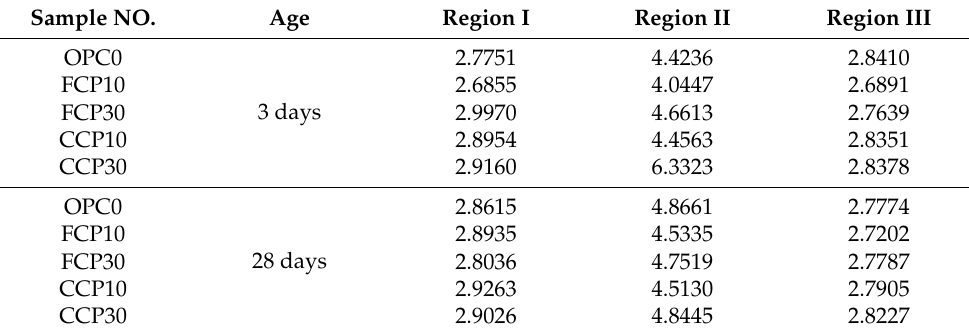
Table 3. Coral powder–cement slurry multifractal analysis by Neimark’s model. Sample